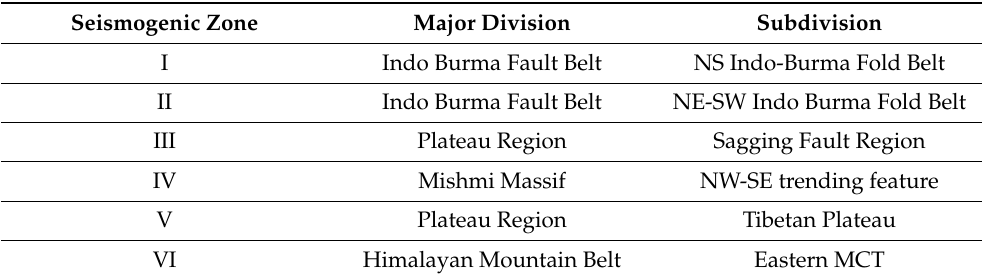
Table 1. Different Seismogenic zones for Northeast India.